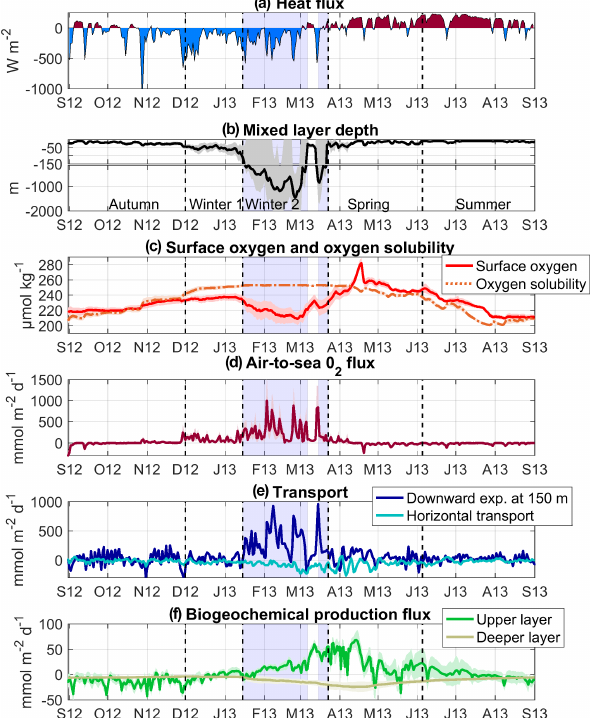
Figure 6. Time series of modelled (a) total heat fluxes (Wm − 2 ), (b) mixed-layer depth (m), (c) surface oxygen and oxygen solu- bility (µmolkg − 1 ), (d) air-to-sea oxygen fluxes (mmolm − 2 d − 1 ), (e) downward oxygen transport at 150m (dark blue) and lat- eral oxygen transport towards the convection area (light blue) (mmolm − 2 d − 1 ), and (f) biogeochemical oxygen production (see Eq. 1) (mmolm − 2 d − 1 ), spatially averaged over the convection area (spatial mean in solid line and shaded area for SD). Sources: ECMWF for heat fluxes, SYMPHONIE/Eco3M-S for the other pa- rameters and fluxes. The blue shaded area corresponds to the deep- convection period (period when spatially averaged MLD > 100m). Note that the range of the y axis varies for the different oxygen fluxes, and due to higher values SD for vertical and lateral transport is not